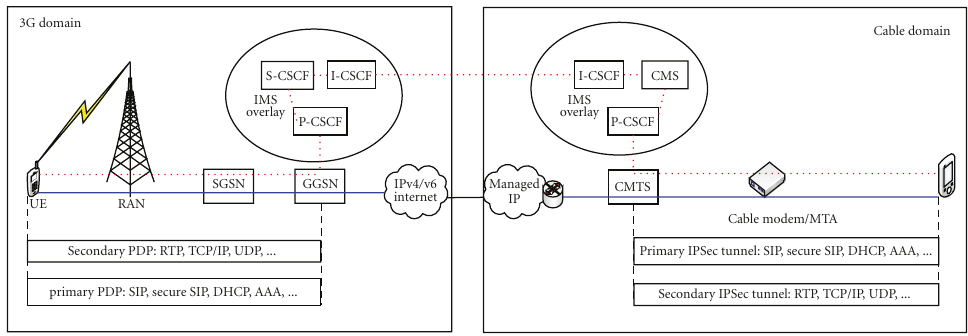
Figure 8: Resource reservation for media and